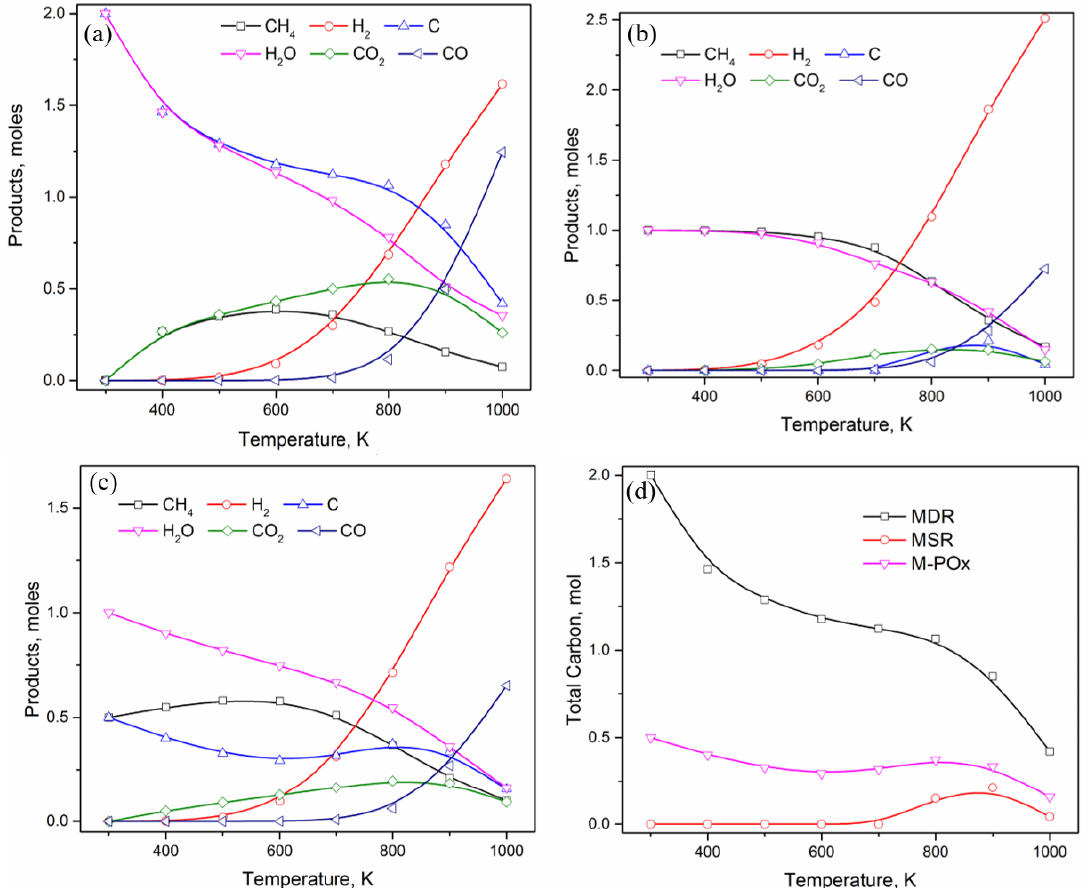
Figure 1. Product distribution in ( a ) methane dry reforming, ( b ) methane steam reforming, ( c ) methane partial oxidation, ( d ) total carbon formation in all the three reactions. All the calculations were performed at 1 atm pressure.